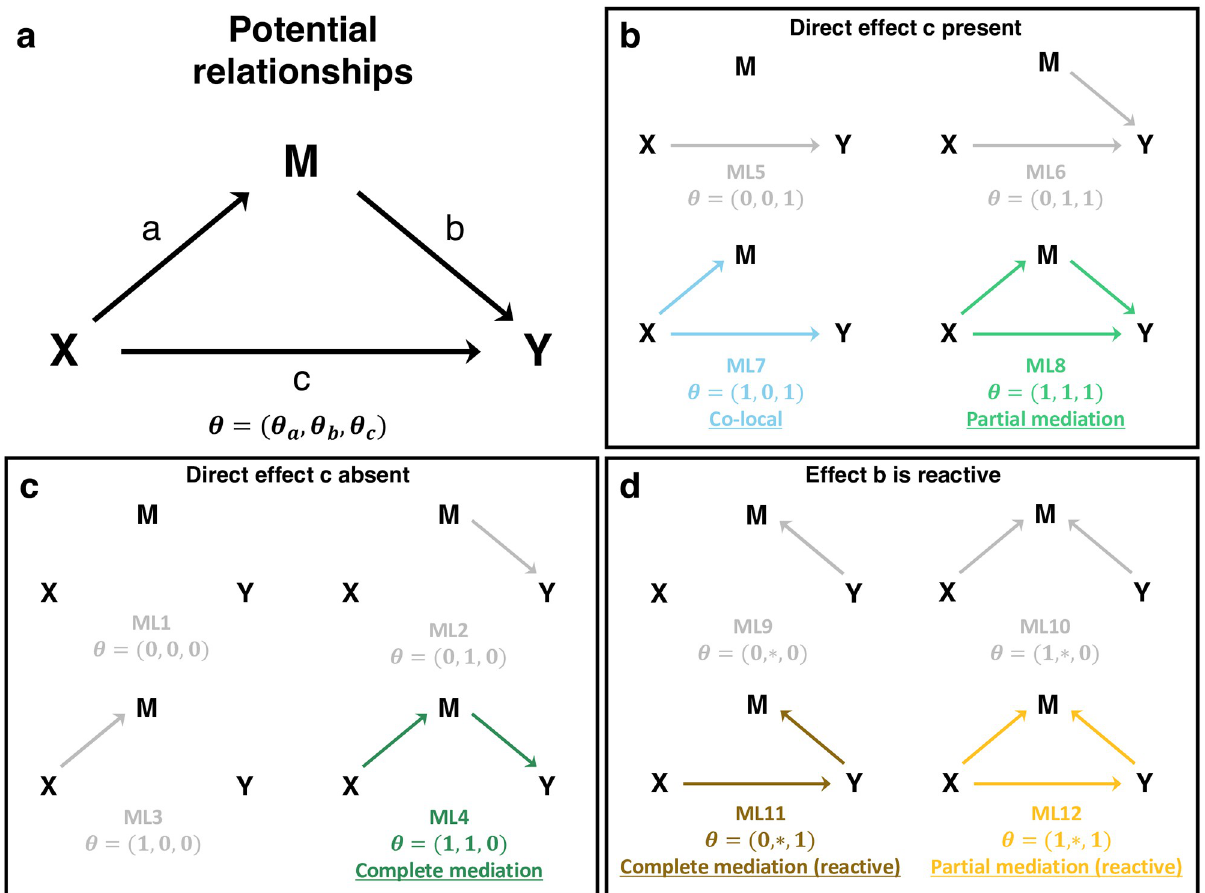
Fig 1. Possible relationships among X, M, and Y. X is assumed to be exogenous, and thus M and Y have no effects on X. A model and corresponding marginal likelihood (ML) are defined by the presence or absence of any of the three edges a , b , and c according to an indicator variable θ . In this work and by default in bmediatR, the direction of edge b is assumed to be from M to Y (M ! Y), but a set of reactive models can also be accommodated in which the direction of edge b is reversed (M Y), indicated with θ = ( θ a , � , θ c ). Models can be favored or even excluded by adjusting the model priors. By default, there are five models (ML1–3 and ML5–6) that represent non-mediation, i.e. , the effect of X on Y, if present, is not mediated through M. The co-local model (ML7) represents a special case where there is no mediation between X and Y, but X independently affects M and Y. The complete mediation model (ML4) and the partial mediation model (ML8) represent cases where the effect of X on Y is explained, completely or partially, by the effect of X on